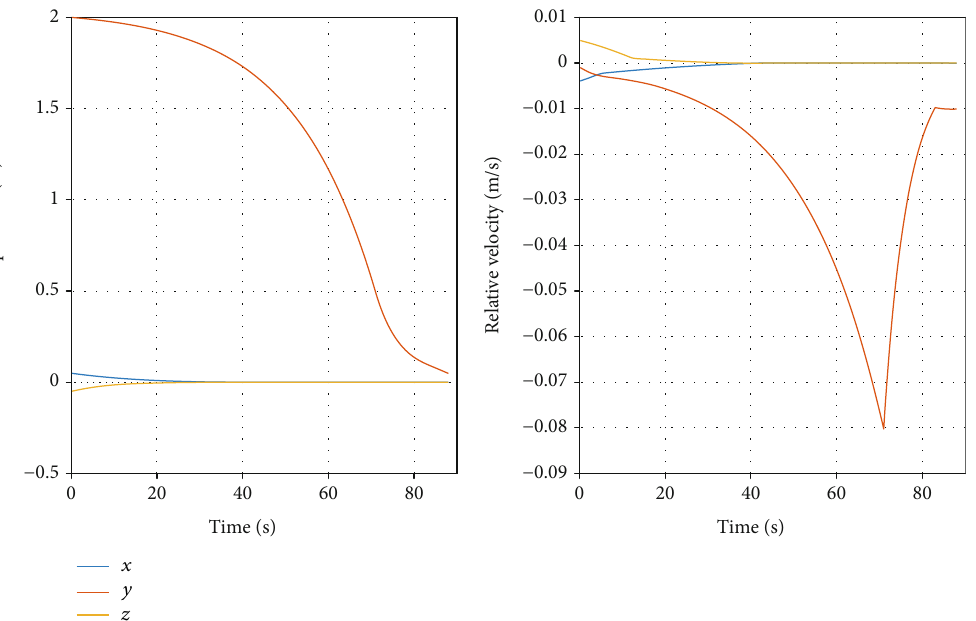
Figure 17: Relative position components and relative velocity components.